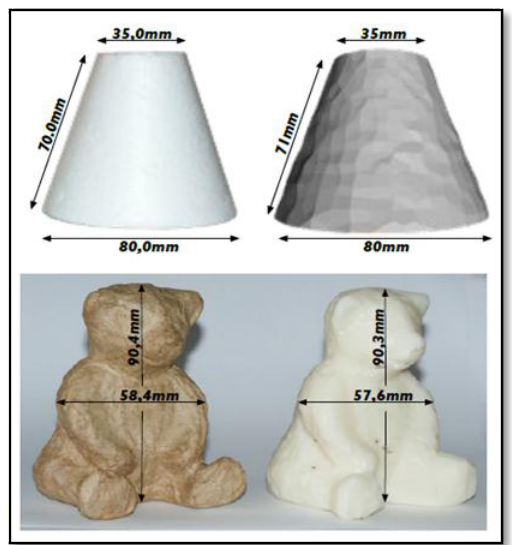
Figure 2. Comparison of the real object (left side) and retort (right side) (Engelmann, 2011)